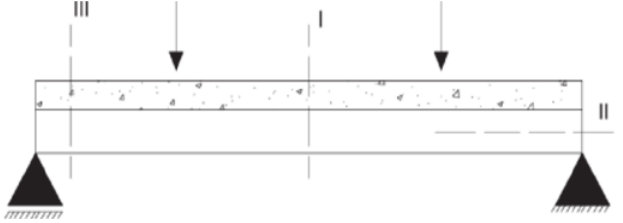
Figura 2 Modos de colapso do sistema misto Fonte: SIEG, 2015, p.